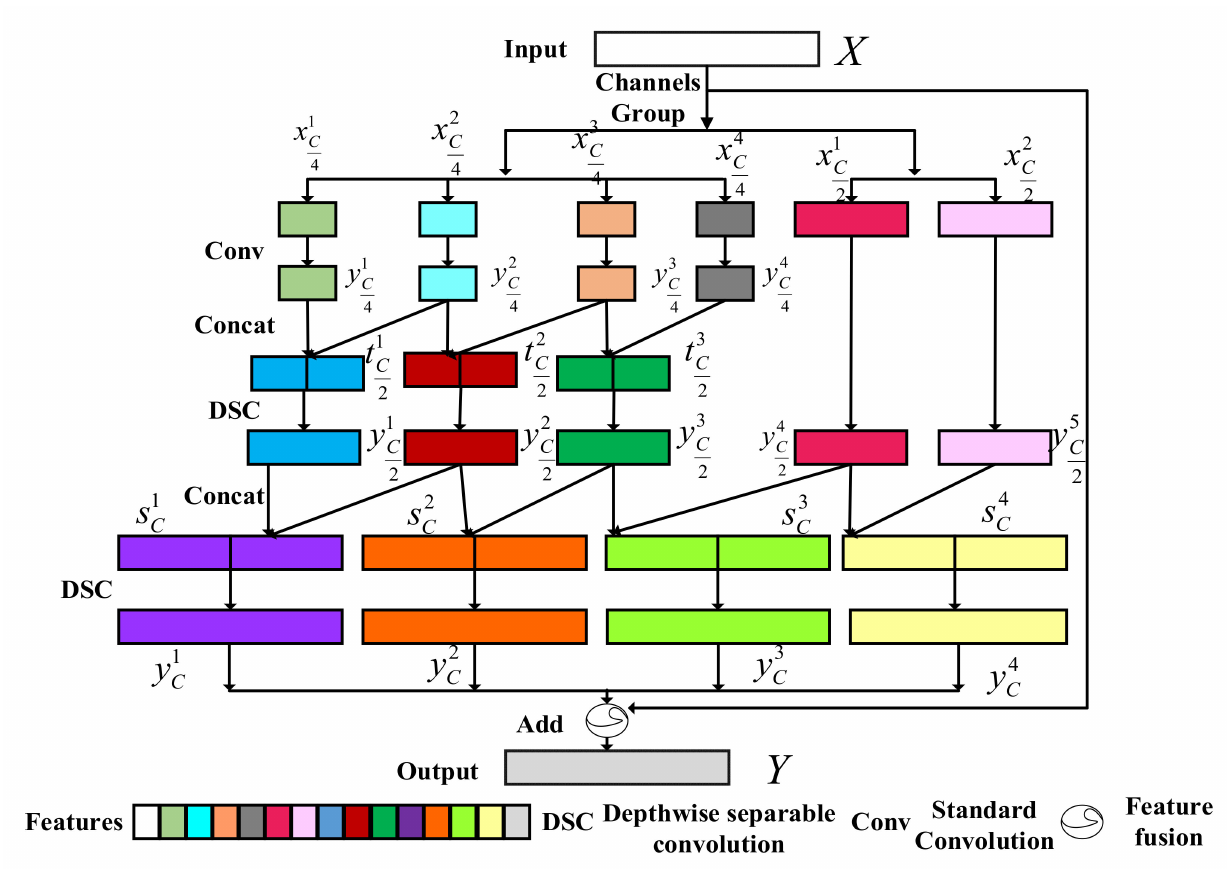
Figure 4. Channel multi-group fusion